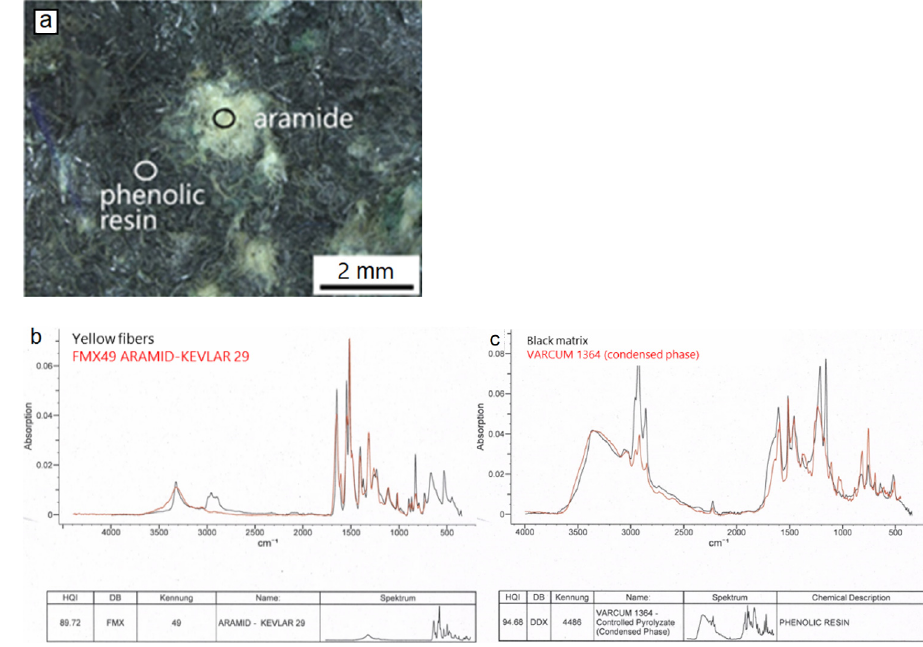
Figure 8. Light microscopic image ( a ) illustrating representative examples of aramid aggregates and phenolic resin matrix (circles) at the pad interior, close to the metal support. FTIR Spectra ( b , c ) of the pad parts (black lines) as well as of the corresponding reference materials (red lines).